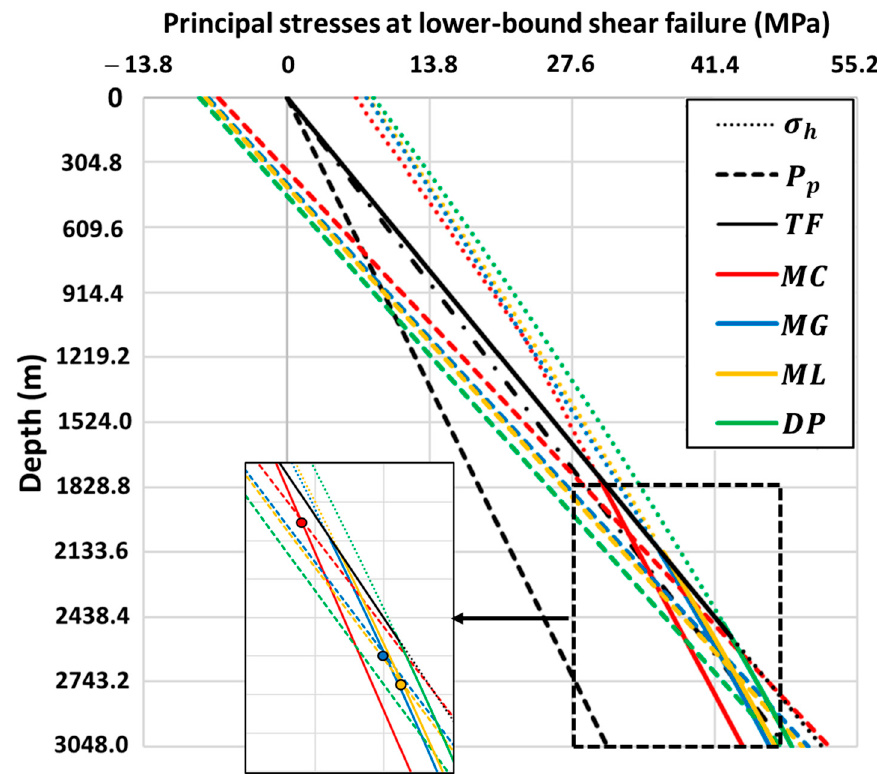
Figure 13. Critical wellbore pressure at lower- (colored dashed), upper-bound shear (colored solid) and tensile (TF; black solid) failures under the normal faulting case with the vertical, maximum, and minimum horizontal stress gradients of 22.6, 20.4, and 15.8 kPa / m, respectively. The internal friction angle is 15 ◦ . The pore pressure gradient is 10.2 kPa / m (black dashed). The wellbore pressures were calculated by the Mohr–Coulomb (MC; red), Mogi–Coulomb (MG; blue), modified Lade (ML; yellow), and Drucker–Prager (DP; green) failure criteria. The minimum horizontal in-situ stress is depicted with the dash-dotted black line. The magnified frame indicates that the lower and upper critical wellbore pressures cross at certain depths, according to the MC (red circle), MG (blue circle), and ML criteria (yellow